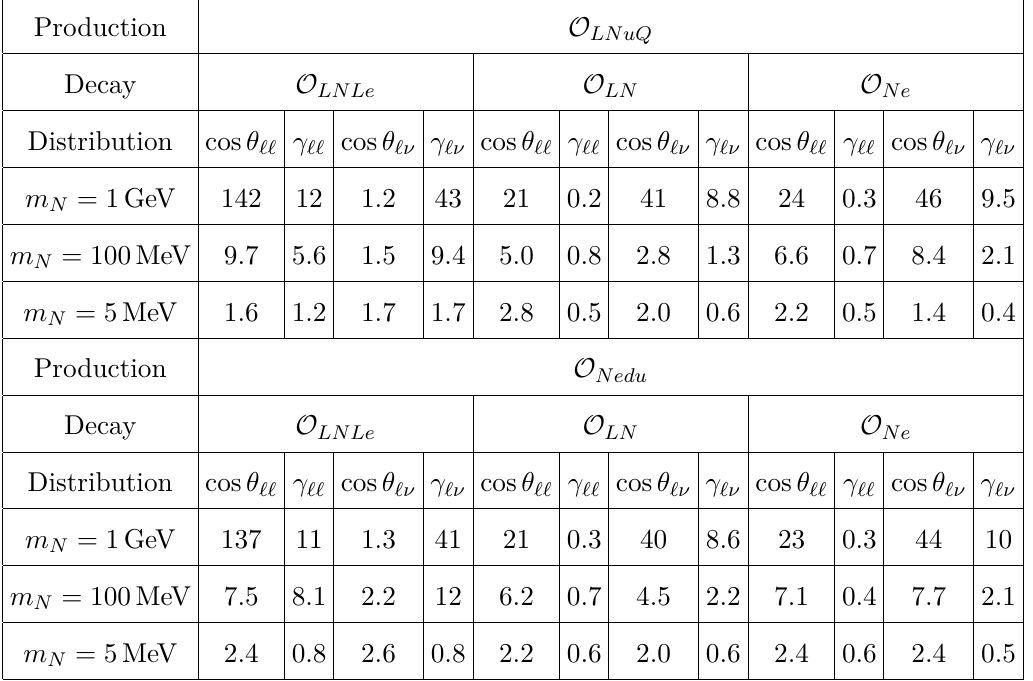
for two-body B decay for various min